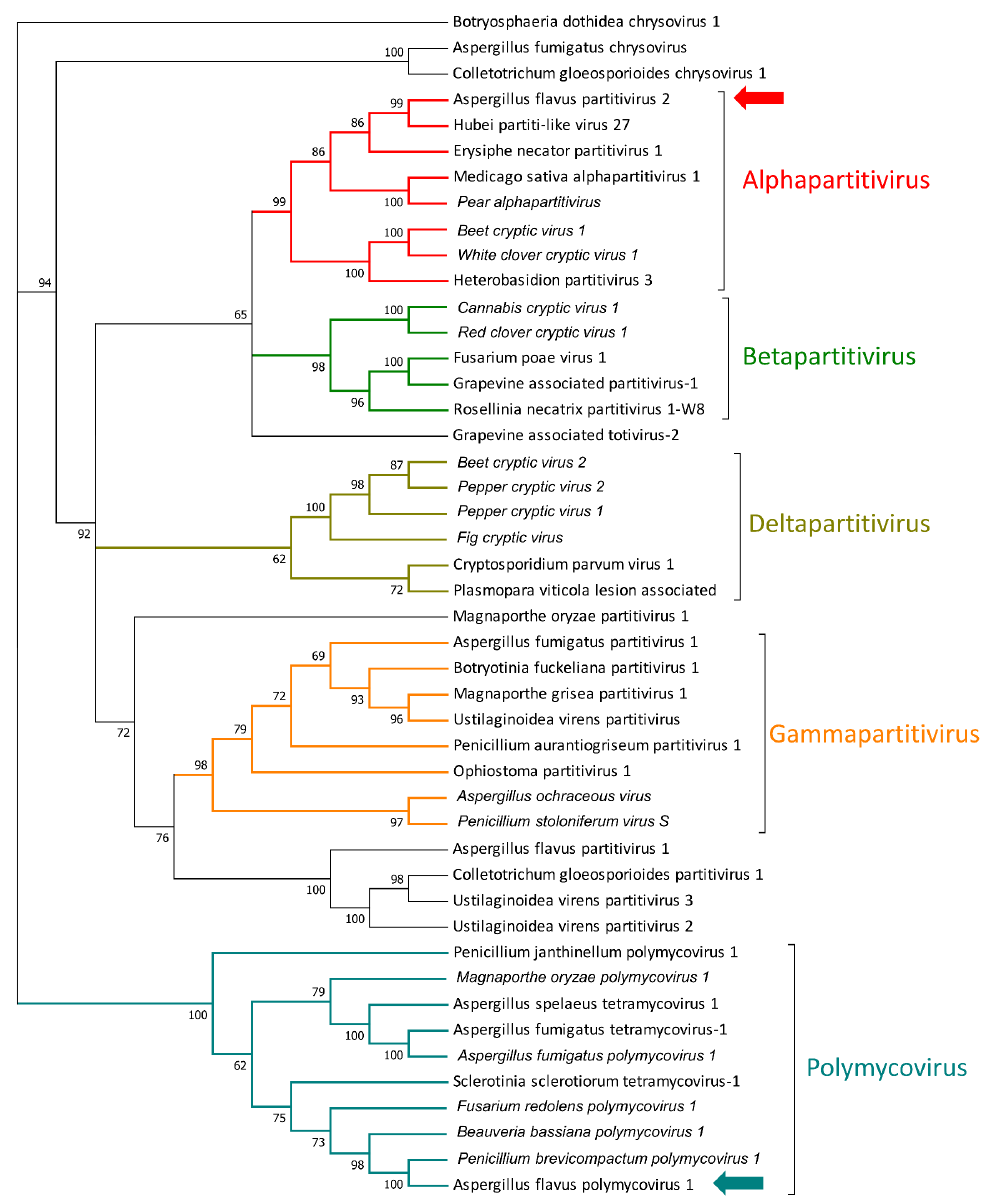
Figure 4. Phylogenetic relationship of viruses displaying a double-stranded RNA (dsRNA) genome. Amino acids’ sequences of RNA-dependent RNA polymerases (RdRps) were aligned using MUSCLE, and phylogeny were then derived using the likelihood methodology in IQTREE. Numbers above branches represent statistical support based on bootstrap analysis (1000 replicates). Viruses identified in this work are indicated by colored arrows.